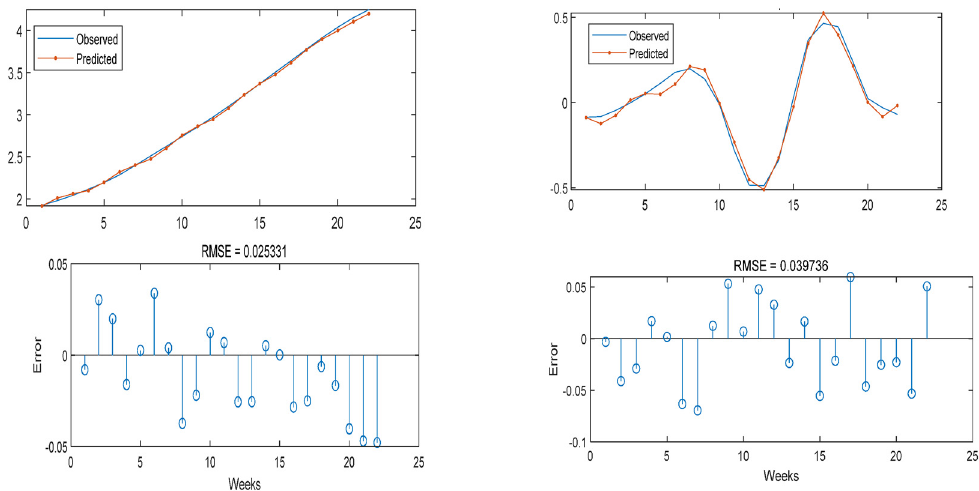
Figure 9. Prediction results and error images of the ANN-WT-LSTM model for high-frequency and low-frequency parts of the Do verification set.